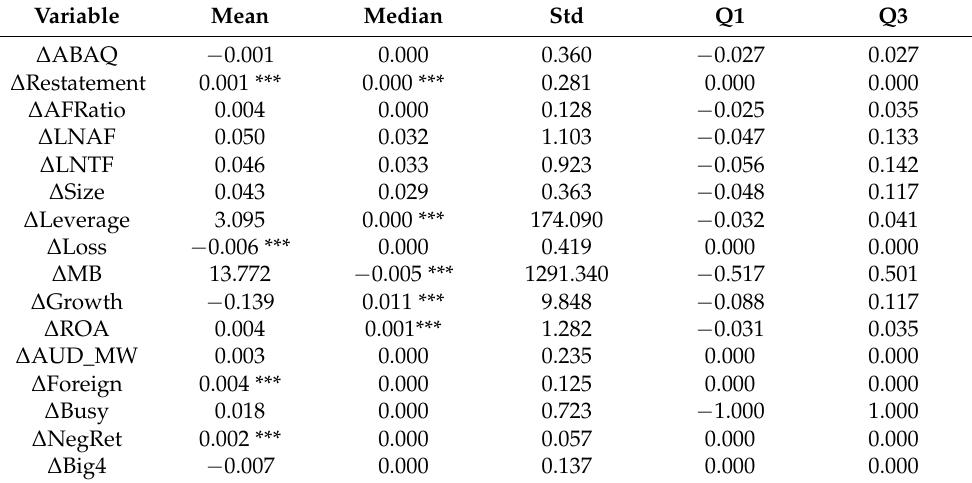
Panel H: Descriptive Statistics for the ABAQ, Restatement, and AF of U.S. sample firms in 3-year post-Rule 3211 period, after